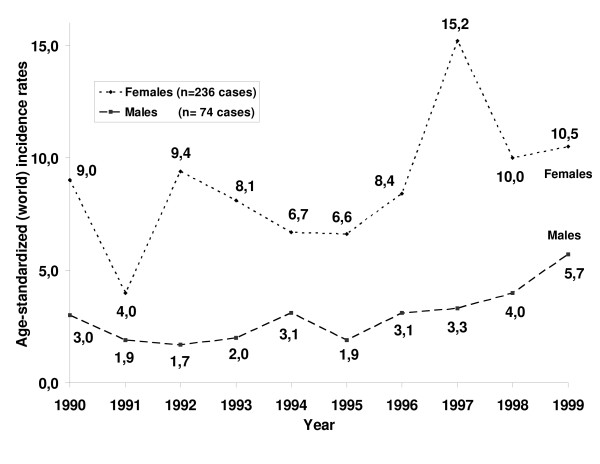
Time trend of the age-standardized (world population) incidence rates of thyroid carcinomas (n = 310) by gender; 1990–1999.